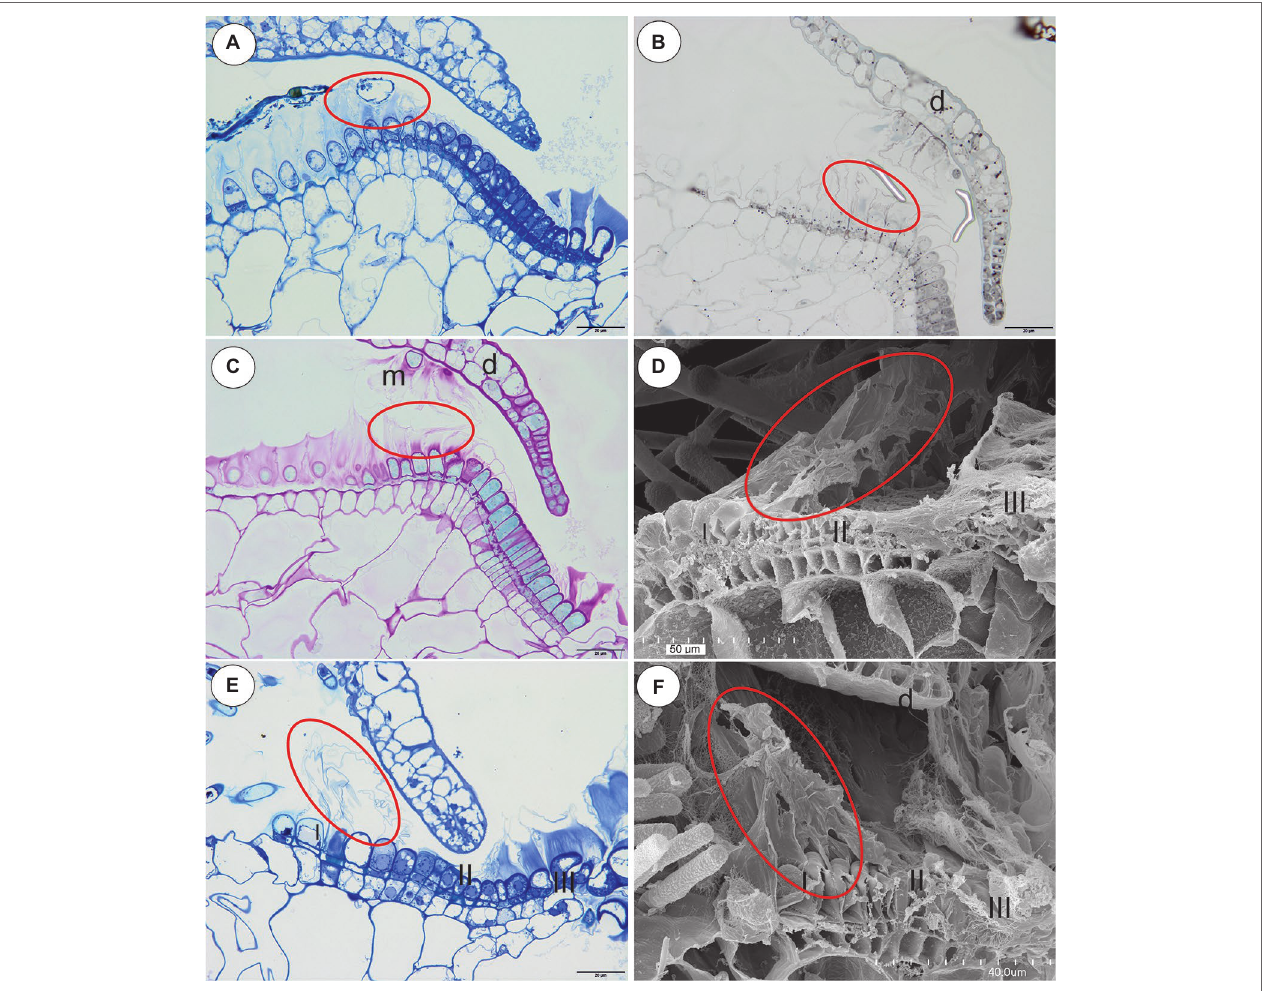
FIGURE 4 | The structure and cytochemistry of the pavement epithelium of Utricularia uniflora , the structure of the pavement epithelium of the Utricularia species; section Calpidisca . (A) A longitudinal section of the pavement epithelium of Utricularia uniflora , note the velum (ellipse); scale bar = 20 μ m. (B) Utricularia uniflora , a semi-thin longitudinal section of the threshold of the external part showing the trichomes that produce the velum. The lipid stain SBB was absorbed by the cuticles (ellipse); scale bar = 20 μ m. (C) PAS reaction, note the intensive production of mucilage in zones I. II and IV of the pavement epithelium, and also the mucilage trichomes on the surface of the door (m), door (d); scale bar = 20 μ m. (D) SEM image of a longitudinal section of a Utricularia sandersonii trap entrance, note the external zone (I) in which the trichomes produce velum (ellipse), the middle zone (II) and the internal zone (III) with the mucilage trichomes; scale bar = 50 μ m. (E) A semi-thin longitudinal section of the pavement epithelium of Utricularia sandersonii , note the three zones of the pavement epithelium (I, II, III), the velum (ellipse); scale bar = 20 μ m. (F) SEM image of a longitudinal section of Utricularia livida , note the external zone (I) in which the trichomes produce the velum (ellipse), the middle zone (II) and the internal zone (III) with the mucilage trichomes, door (d); scale bar = 50 μ